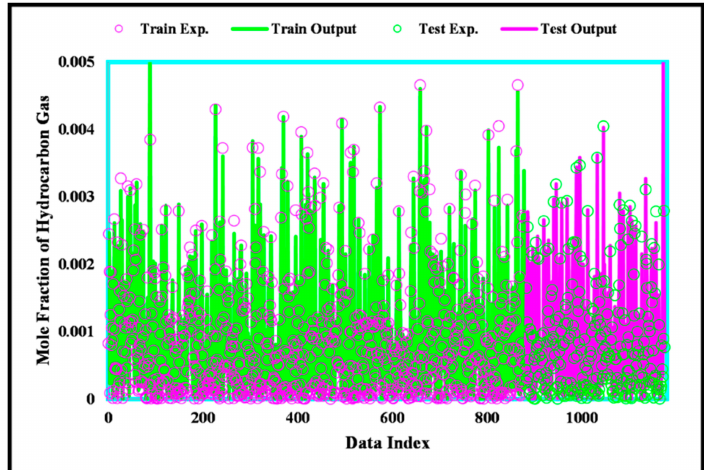
Figure 3. Comparison of actual and estimated solubility of hydrocarbons.